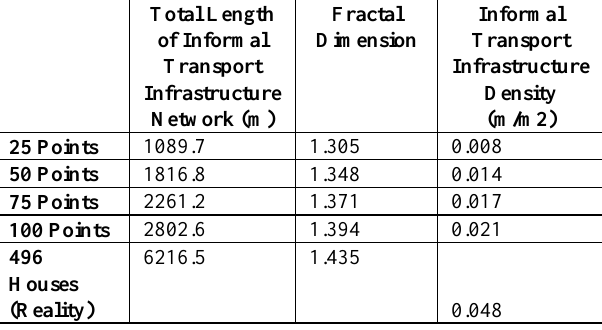
Table 2. Total Length of Informal Transport Infrastructure Network , Fractal Dimension, Informal Transport Infrastructure Density Values for the Case Study (Simulation Runs and